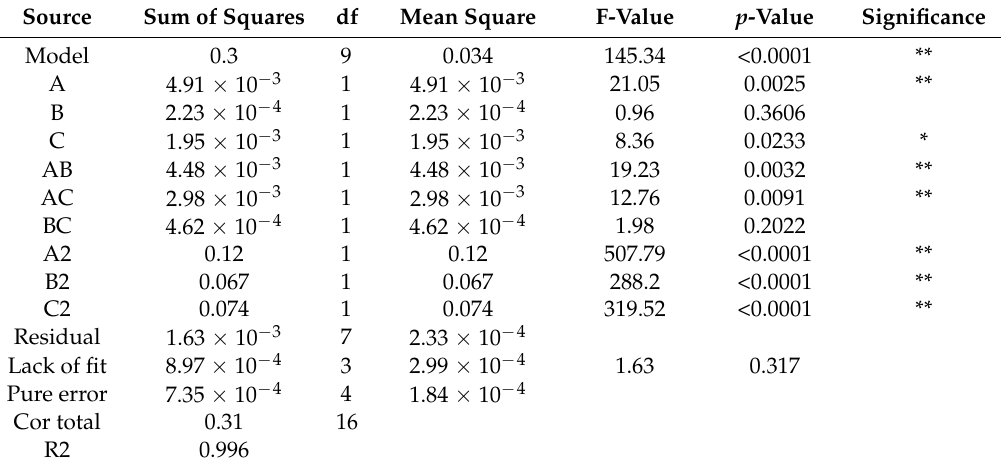
Table 2. Analysis of variance (ANOVA) for the experimental